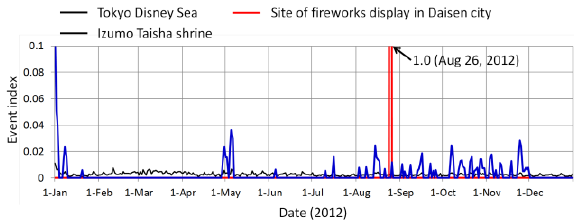
Figure 11. Event indices of Event Mesh that has characteristic temporal transition of Event visitor (Tokyo Disney Sea, Site of fireworks display in Daisen city and Izumo Taisha shrine)